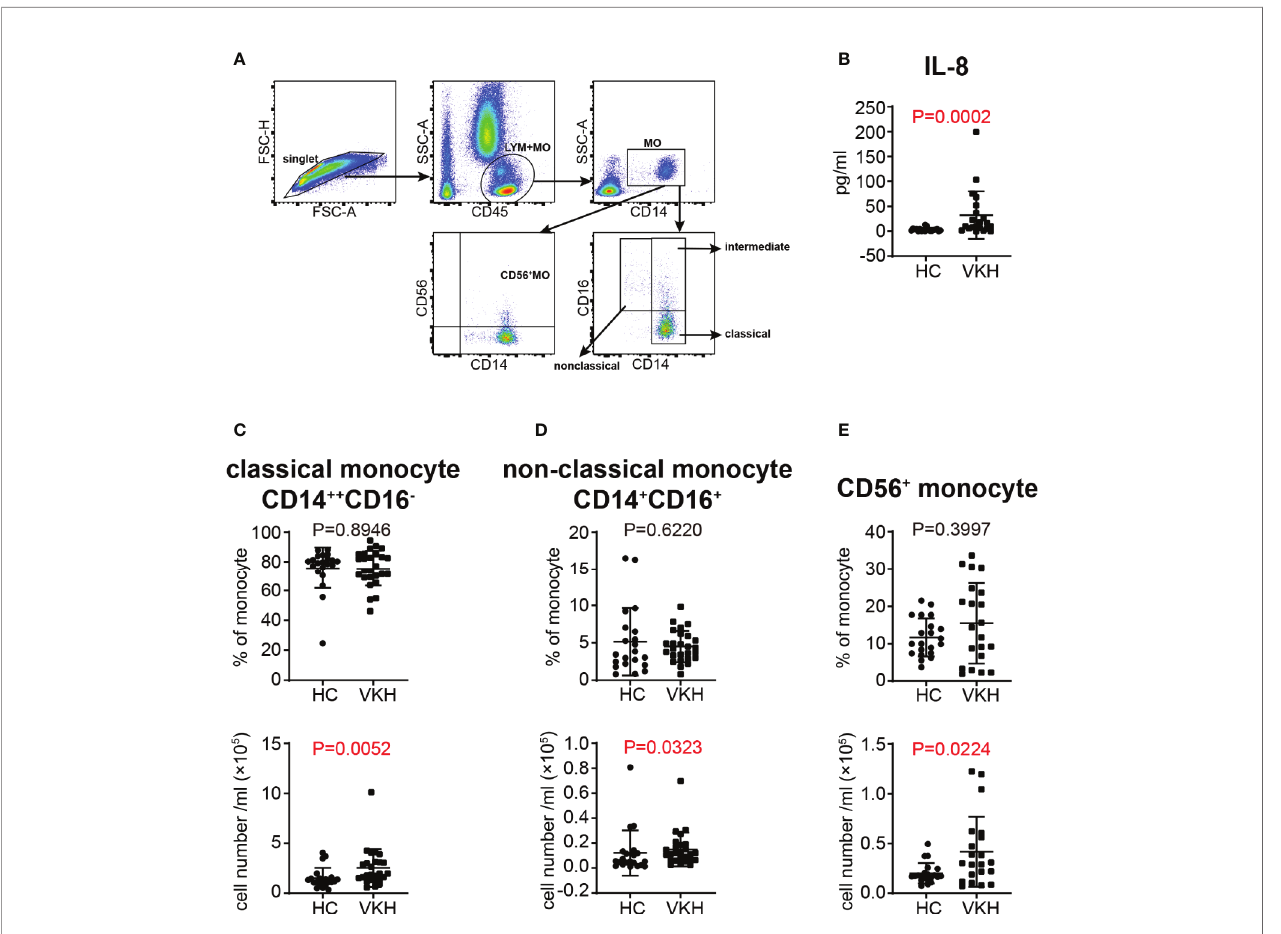
FIGURE 5 | Changes of monocyte subsets in VKH patients compared with healthy controls. (A) Gating strategy used for the characterization of monocyte subsets. (B) Plasma level of IL-8 (pg/ml) of HCs and VKH patients. The absolute number and proportion of (C) classical monocytes, (D) non-classical monocytes and (E) CD56 + monocytes. Statistical analysis was performed using Mann – Whitney